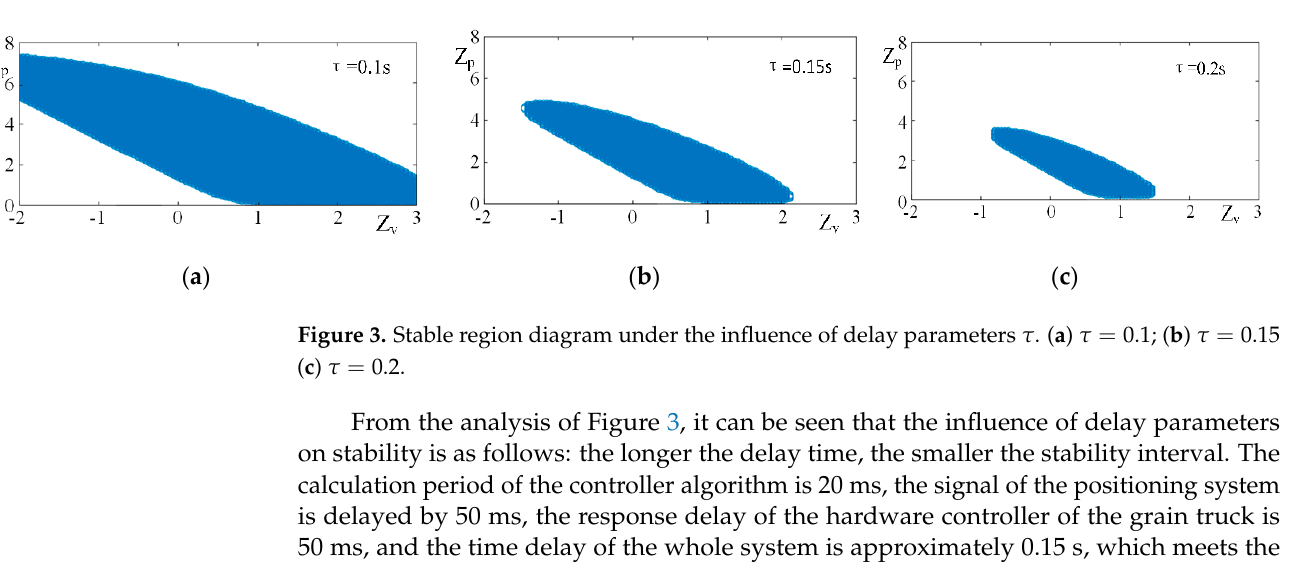
7 of 15 Figure 2. ( a ) Grain truck and crop harvester follow system stability; ( b ) Bode diagrams of stability at different boundaries. Three parameters are selected from Figure 2a to plot the stability, as shown in Figure 2b. Point A is selected from the interior of the stability interval, point B is selected from the boundary of the stability area, and point C is selected from the outside of the stability area. Comparing the three points A, B, and C, it can be seen from Figure 2b that the mag- nitude of the two points A and B are always less than or equal to 0, which matches the multi-machine driving stability conditions of agricultural machinery. The velocity fluctu-